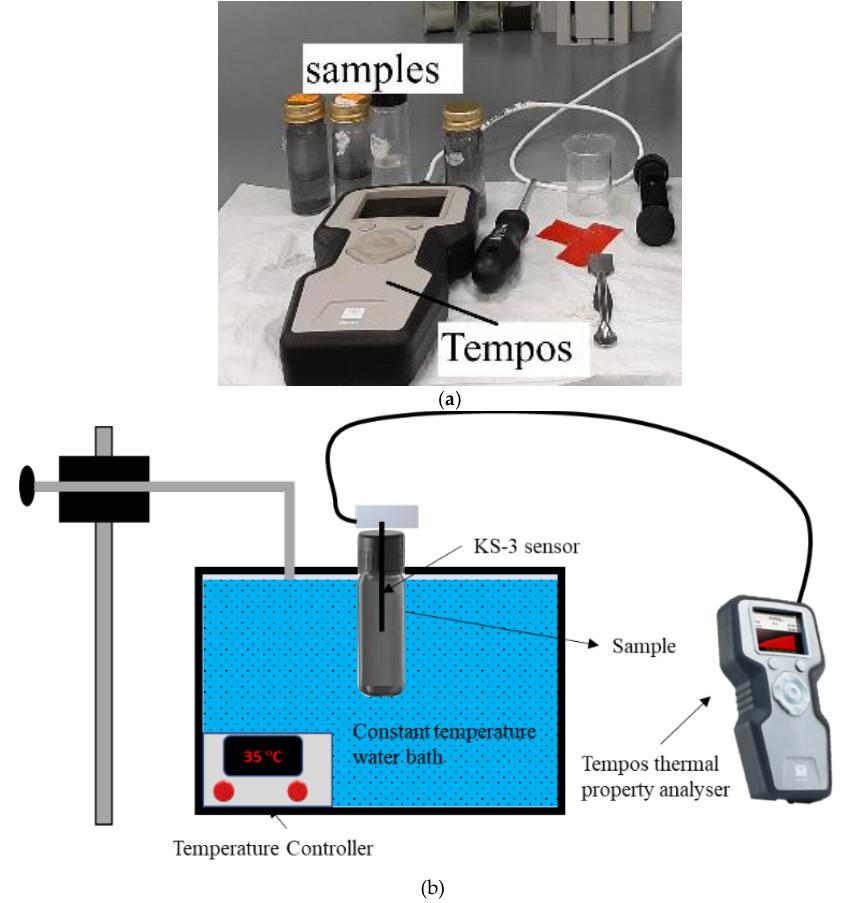
Figure 2. ( a )Tempos thermal conductivity measuring instrument based on transient hot wire method, ( b ) Schematic of the thermal conductivity measurement setup. ( b ) Schematic of the thermal conductivity measurement